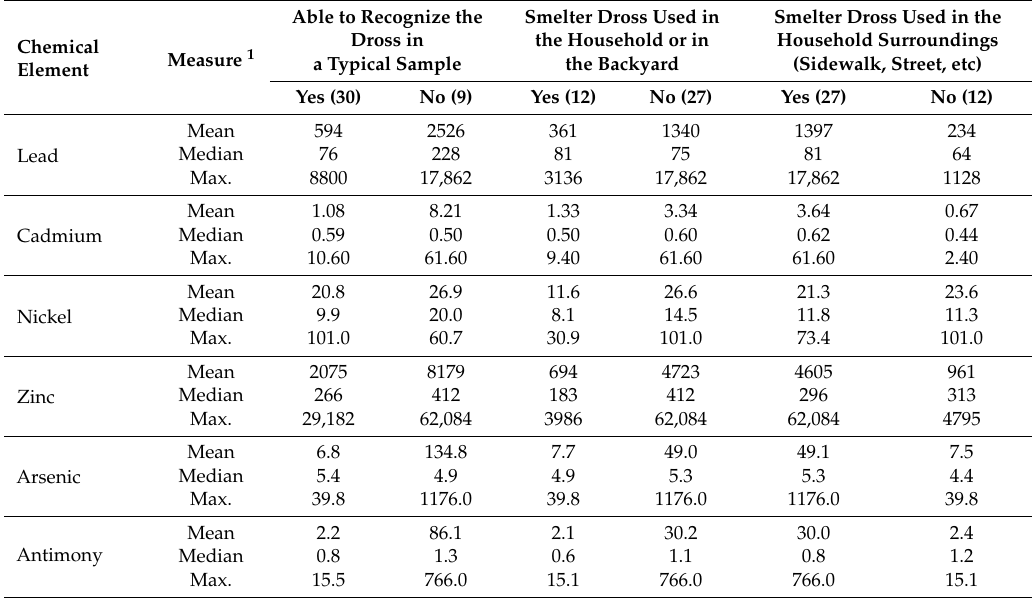
Table 8. The concentrations (ppm) of chemical elements in the soil according to the perception of the hazard by residents in the 39 households from Santo Amaro City,